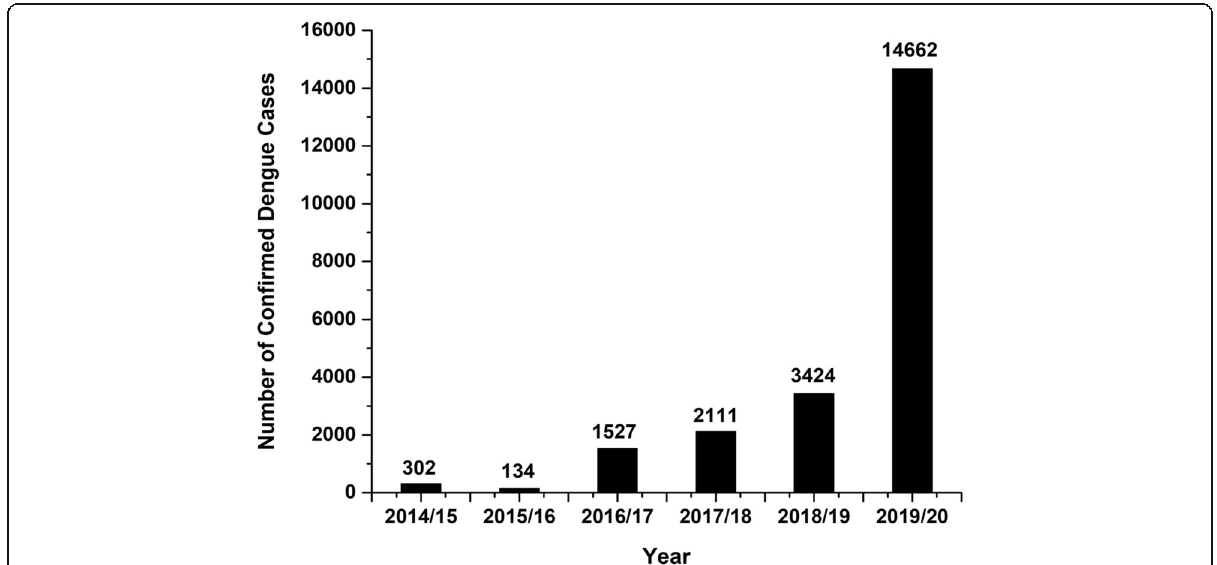
Fig. 2 Confirmed dengue cases in Nepal recorded in each fiscal year starting from 2014/2015 until 2019/2020. Data were collected